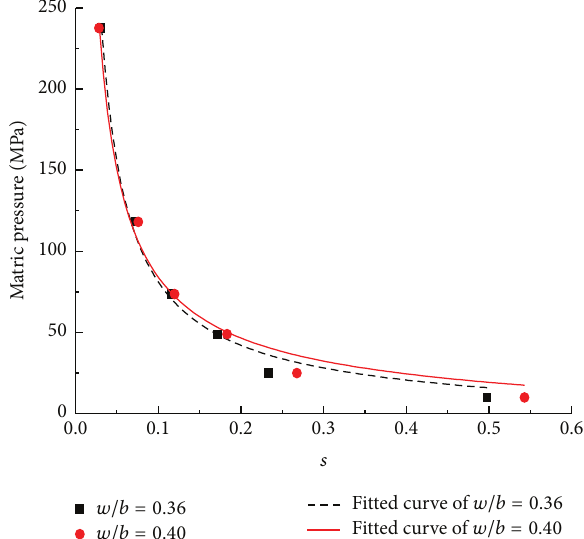
Figure 2: Moisture characteristic curves for the concrete mixtures.